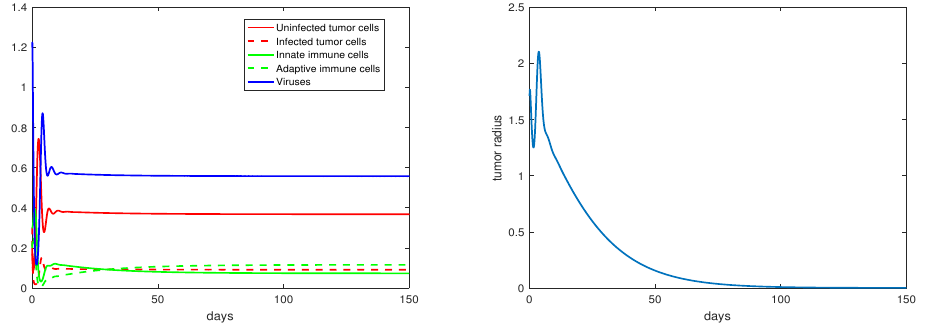
Figure 11. The equilibrium E ∗ = ( 0.38,0.09,0.1,0.082,0.57 ) is asymptotically stable and the tumor radius is exponentially decreasing when R 3 = 2.05 < R 0 = 2.24 < min { λ values of the parameters are: λ = 2, β = 3.5, k 1 = 1, k 2 = 9.3, s 1 = 9, s 2 = 20, c 1 = 1, c 2 = 2, δ = 8, k 0 = 1.5, γ = 2.5, µ = 2.5, b =